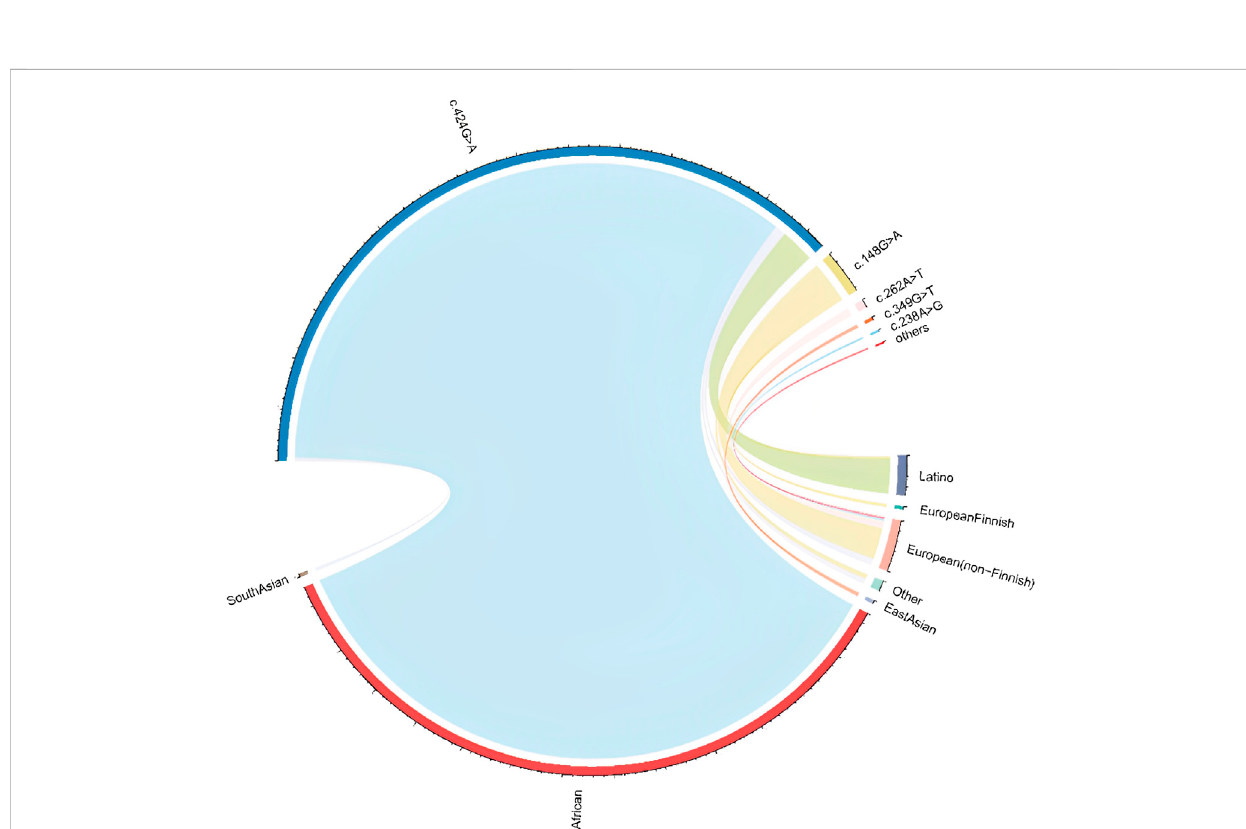
FIGURE 1 Population and pathogenic variant correlation in gnomAD Abbreviations: The ethical information was achieved from gnomAD database. The line connectingrepresentthepathogenicvariantpresentintheethnicpopulation.Thethickertheline,thehighertheproportionofthecorrespondingvariant in that ethnic